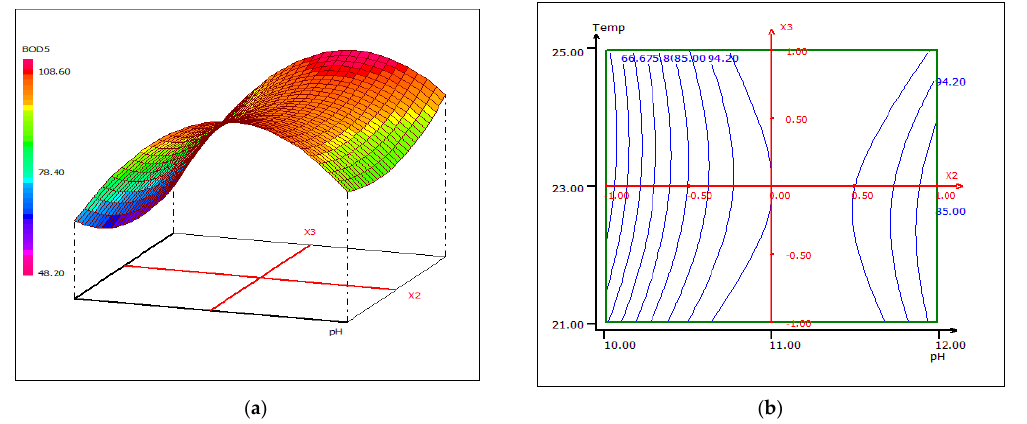
Figure 21. Three-dimensional ( a ) and two-dimensional ( b ) response surface plots for the BOD5 of the treated food wastewater using β -chitin extract as a function of temperature and pH, when the coagulant dose was maintained at 10 mL.